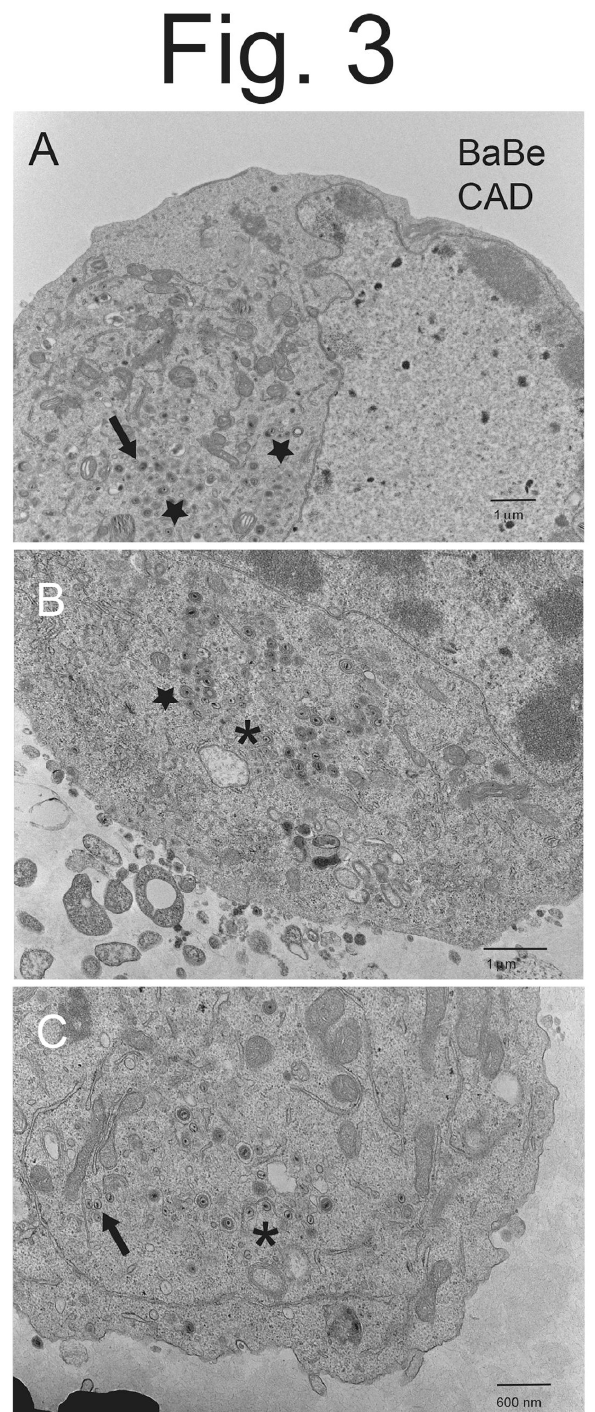
Figure 3. Electron micrographs of CAD neurons infected with PRV BaBe. Differentiated CAD neurons were infected for 10–12 h with PRV BaBe then fixed and processed for EM. Panel ( A ) shows a neuron with few cell surface particles and numerous enveloped cytoplasmic particles, including several that included electron-dense material inside the cytosolic vesicle that might be tegument (stars). There were also numerous unenveloped or partially enveloped capsids (solid arrow). Panel ( B ) shows some cell surface particles that appear misassembled as well as a partially enveloped capsid (asterisk) and misassembled virus particles with an oblong electron density (star). Panel ( C ) shows partially enveloped capsids (asterisk) and unenveloped capsids (solid